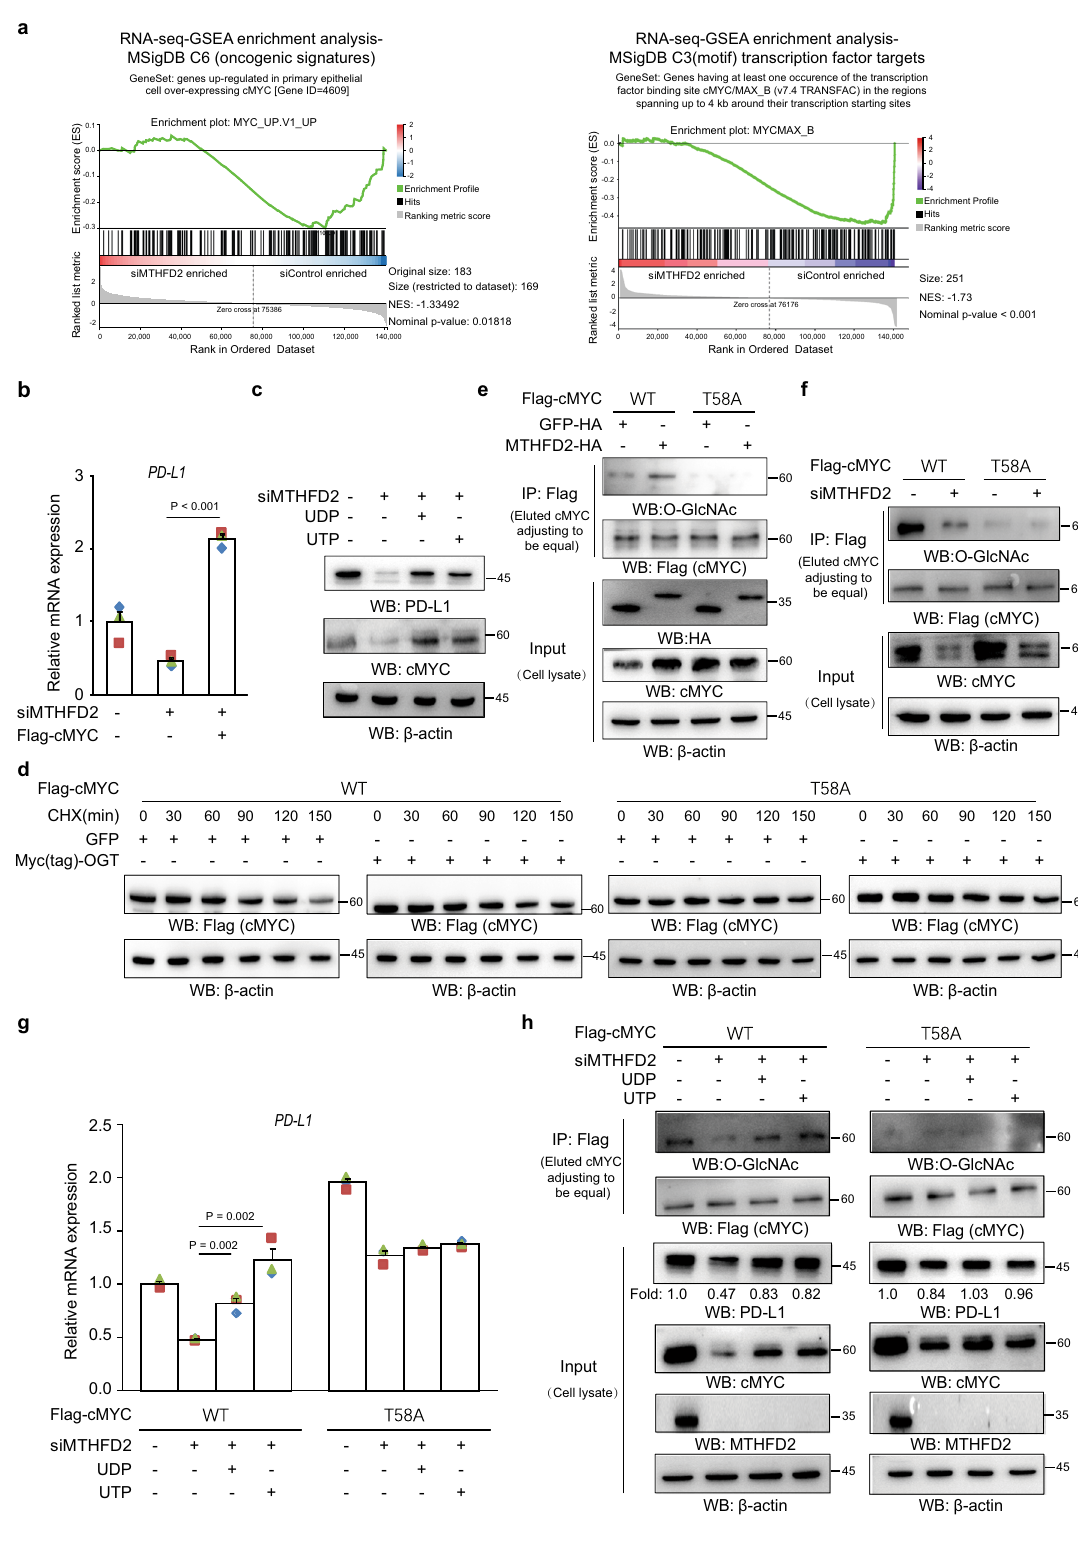
The plenti-MTHFD2-FLAG were generated by cloning MTHFD2 cDNA ordered from DNA core in Shanghai Jiao Tong University into the plenti-GFP- FLAG vector (OBiO Technology) digested by ECORI and BamHI using Syno assembly (Synbio technologies). The plenti-MTHFD2-FLAG-D168E were cloned with mutagenic primers containing desired mutation using the QuikChange II site- directed mutagenesis kit (Agilent Technologies). Primers are shown in Supplementary Data